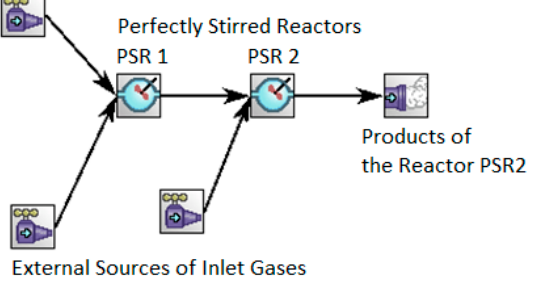
Figure 4. for theoretical analysis in Chemkin solver.